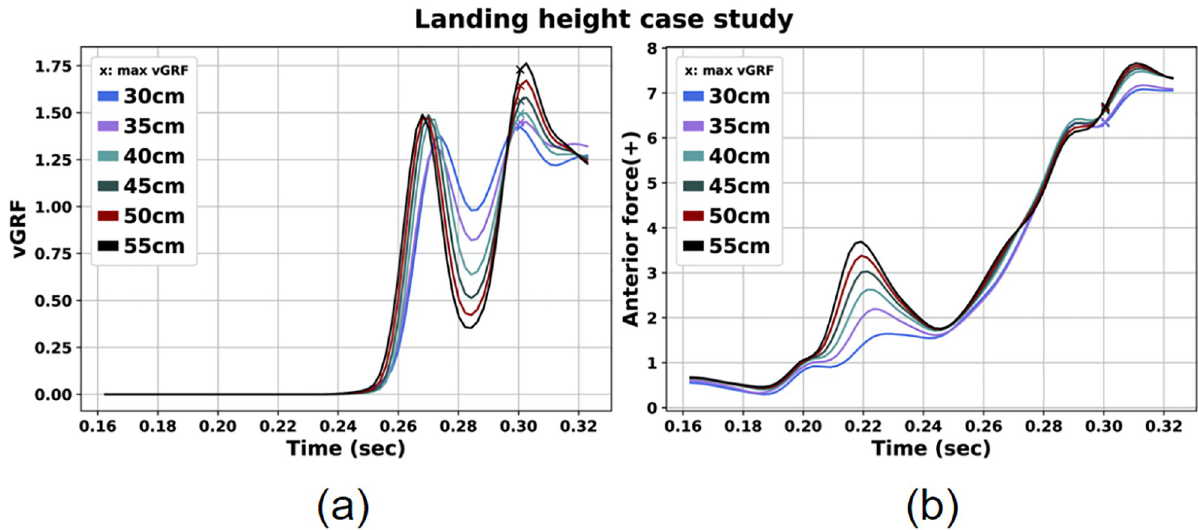
Fig 5. Vertical GRF (a) and, knee joint AF (b) for the landing height case study.